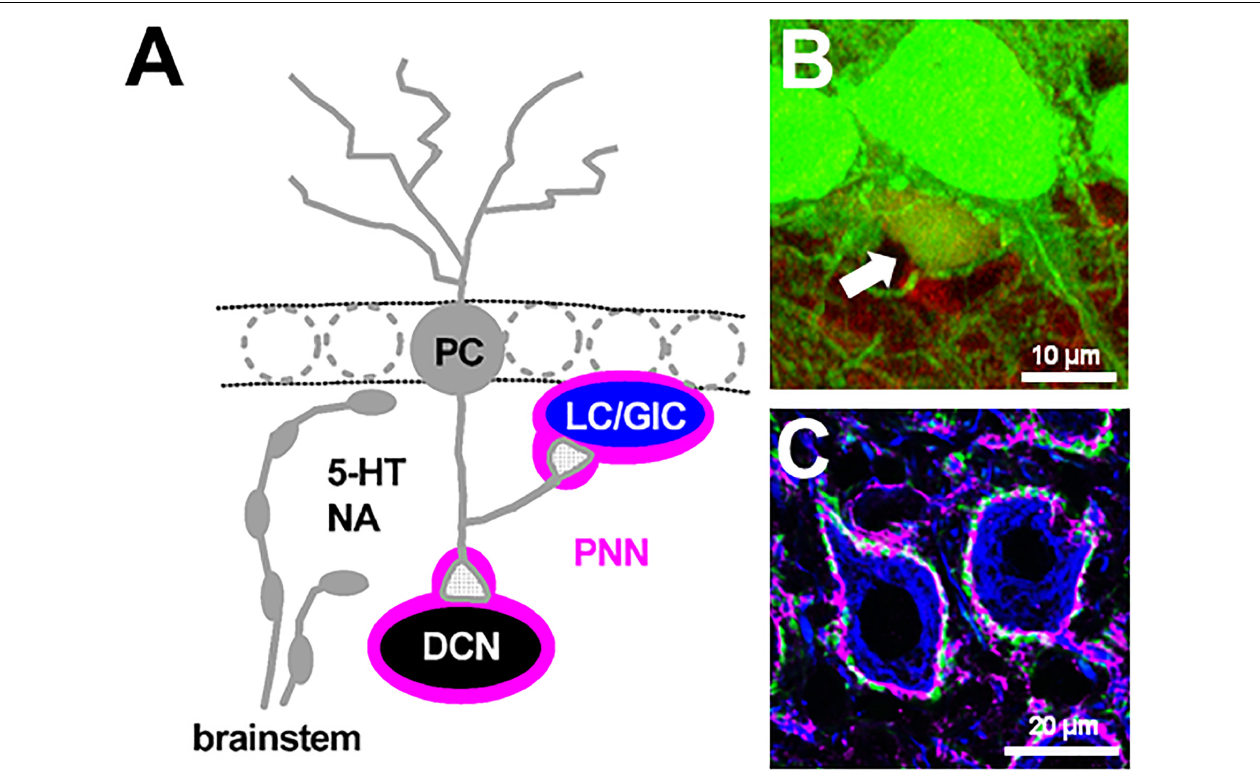
FIGURE 1 | Perineuronal net-expressing cerebellar neurons targeted by Purkinje cells. (A) A Purkinje cell (PC) axon collateral makes GABAergic synapses with a Lugaro/globular cell (LC/GlC). A PC primary axon innervates a large glutamatergic neuron in the deep cerebellar nuclei (DCN). These PC target neurons are enwrapped by perineuronal nets (PNNs). 5-HT and NA are released from their beaded afferent fibers originated from the brainstem. (B) A GlC in the GAD67 + / GFP mouse cerebellum shows immunoreactivity for anti-calretinin antibody (red), thus its cell body is show in yellow (indicated by an arrow). (C) Cell bodies of large glutamatergic DCN neurons are immunolabeled by SMI32 antibodies (blue) and surrounded by PNNs as shown by Wisteria floribunda agglutinin -staining (magenta) and PC axon terminals, which show immunoreactivity against calbindin (green). (B) is from Hirono et al. (2012). (C) is our unpublished